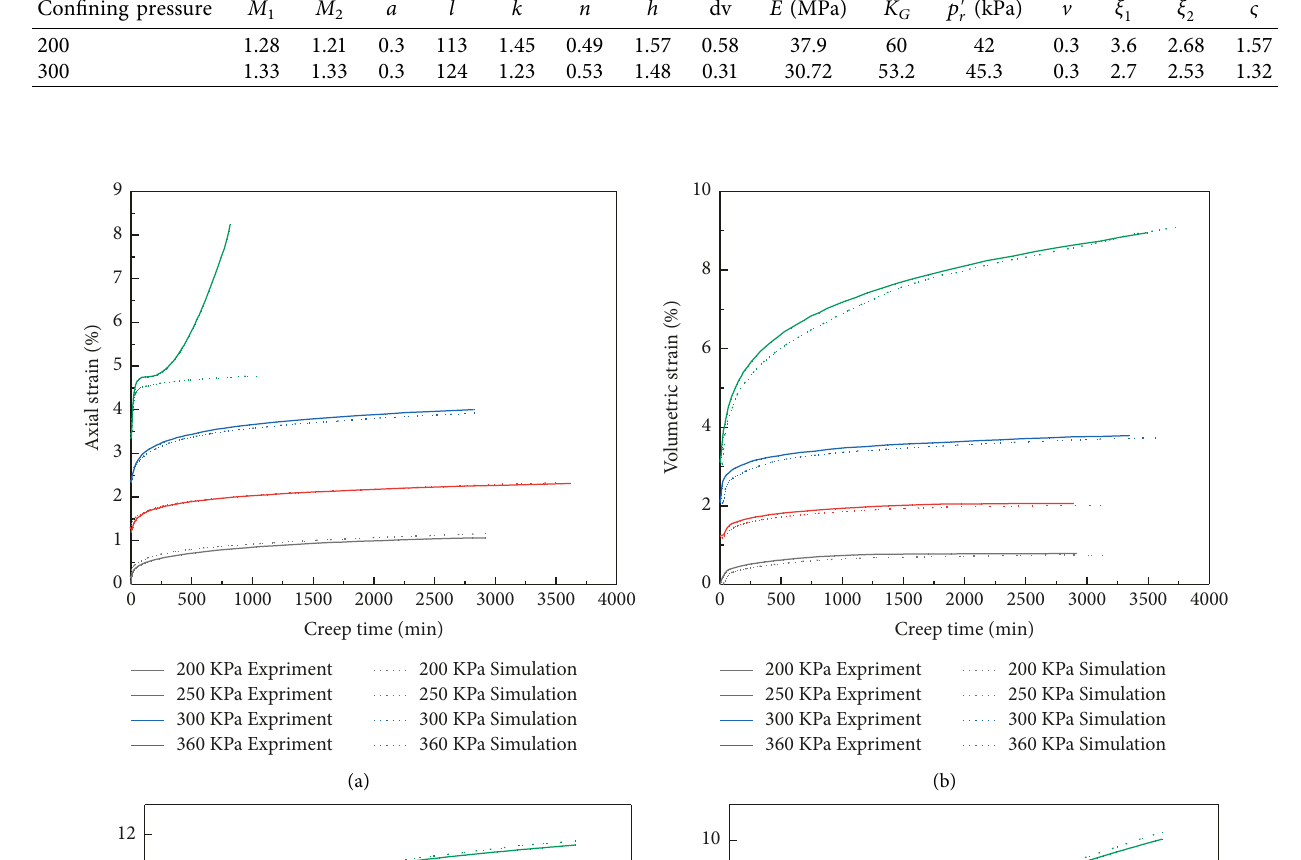
′ � 200kPa); (c) axial strain vs. creep time ( σ 3